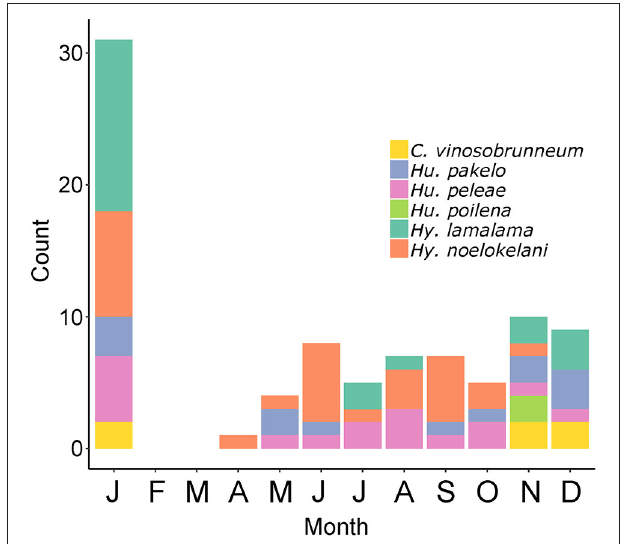
FIGURE 4 | Monthly counts of 87 collections or observations of the six Hawaiian Agaricomycetes species found to be threatened by the IUCN: Callistosporium vinosobrunneum , Humidicutis pakelo , Humidicutis peleae , Humidicutis poilena , Hygrocybe lamalama , Hygrocybe noelokelani . Data from MyCoPortal.org, iNaturalist.org, and MushroomObserver.org.